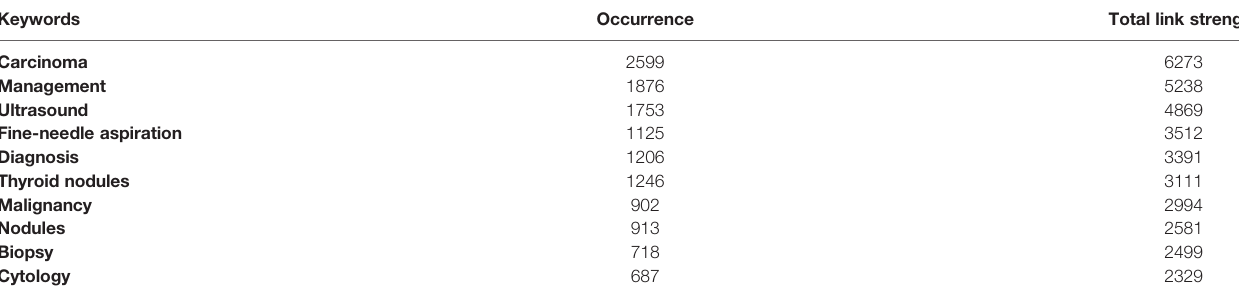
TABLE 1 | Top ten keywords of the study topic most focused on related to thyroid